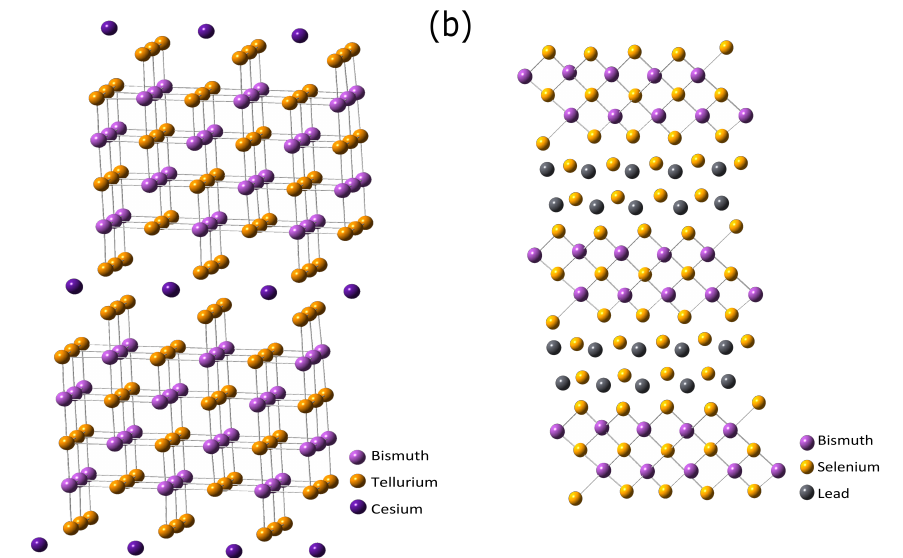
Figure 5: (a) Crystal structure of CsBi 4 Te 6 . (b) Crystal structures of Pb 5 Bi 6 Se 14 .